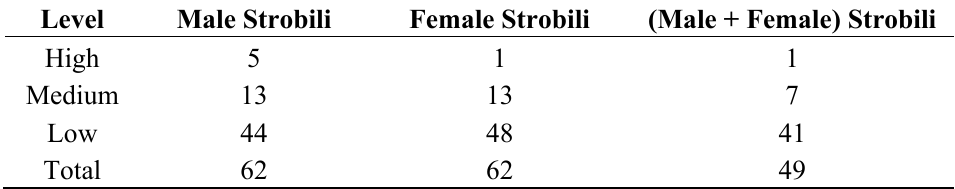
Table 2. Frequencies of Chinese fir parent clones with different strobili numbers.